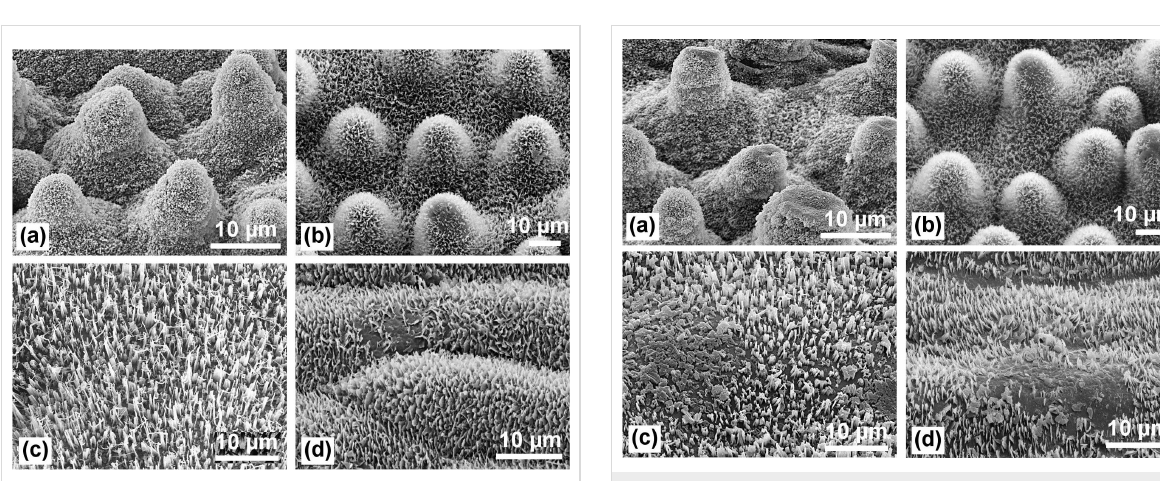
Figure 6: Papillose and non-papillose leaf surfaces with an intact coating of wax crystals: (a) Nelumbo nucifera (Lotus); (b) Euphorbia myrsinites ; (c) Brassica oleracea ; (d) Yucca filamentosa . Even the non-papillose leaves are superhydrophobic. The contact angle of B. oleracea can exceed 160°.